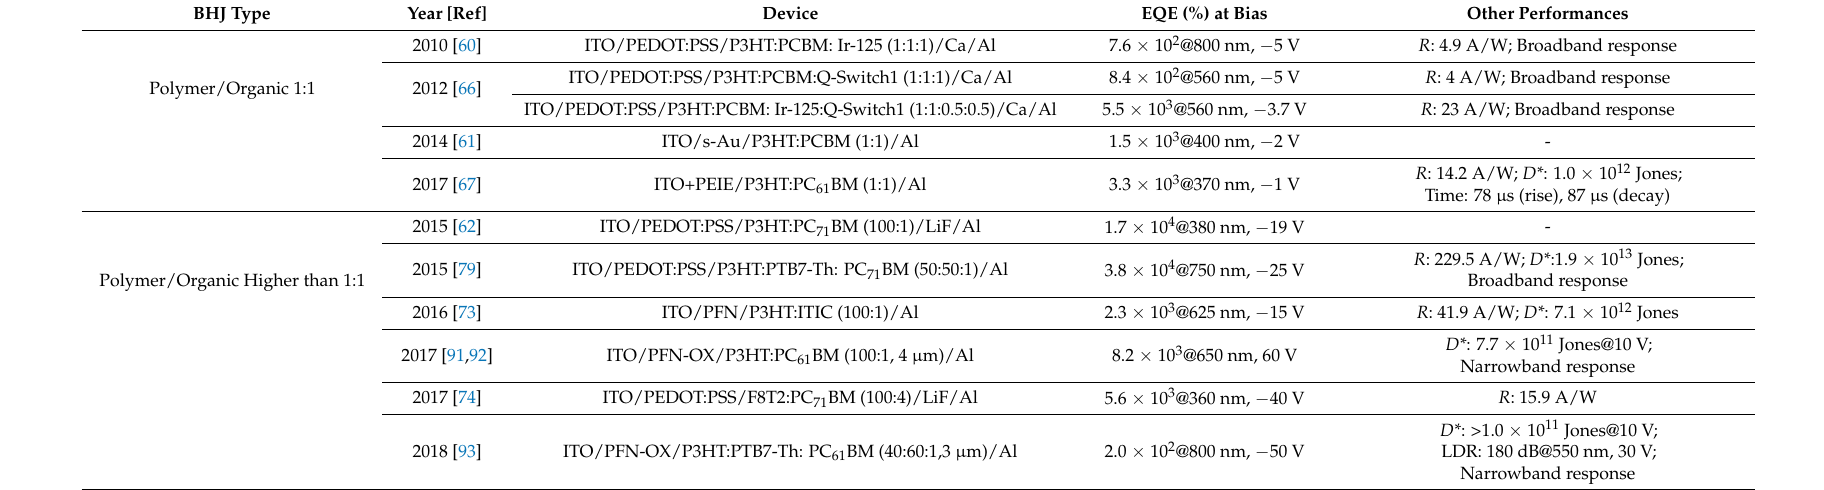
Table 2. Representative organic polymer PM photodetectors and their